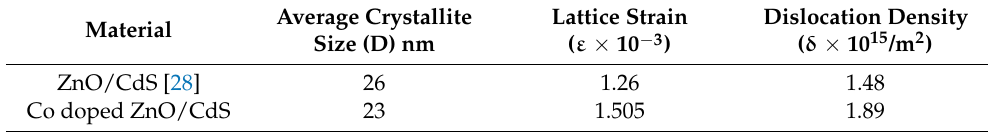
Table 1. Average crystallite size, microstrain, and dislocation density of Co-doped ZnO/CdS nanosheets. Average Crystallite Lattice Material